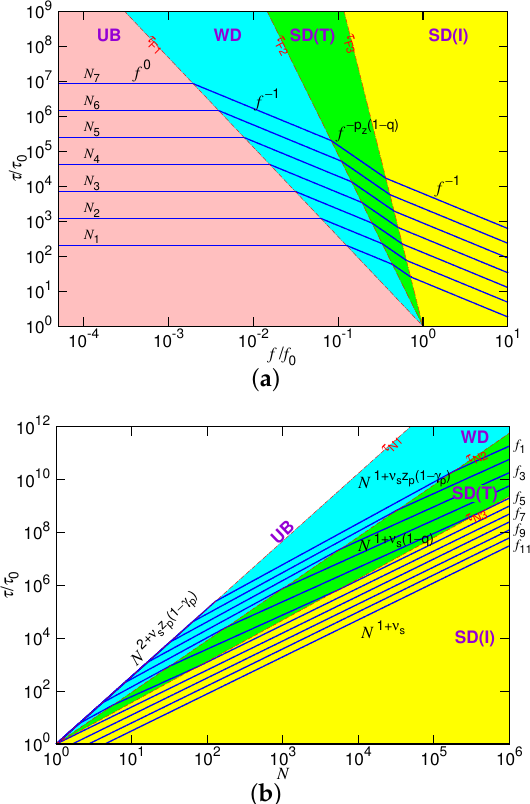
Figure 2. ( a ) Translocation time τ vs. f at different chain lengths N and ( b ) τ vs. N at different driving forces f . In the plots, we set ν s = 0.4, z p ( 1 − γ p ) = 1.4, p z ( 1 − q ) = 1.67 and q = 0.25. In (a), N i + 1 = 2 N i with N 1 = 8; in (b), f i + 1 = 2 f i with f 1 = 1/128. UB, unbiased; WD,